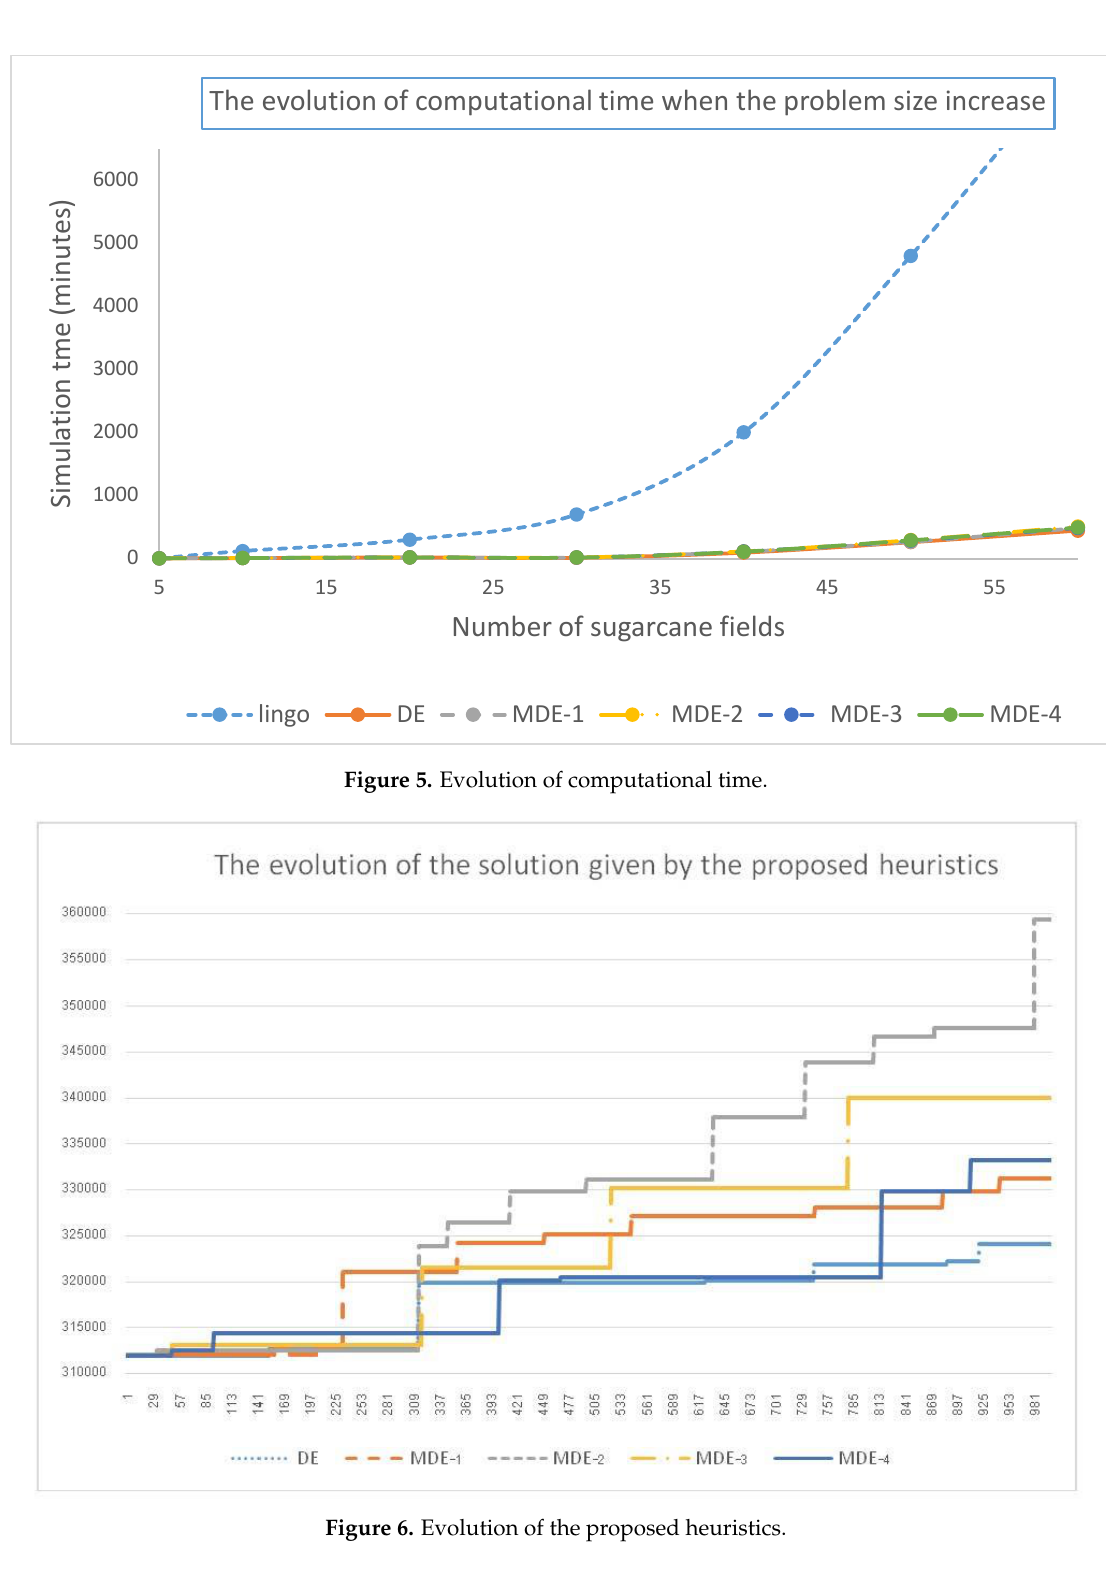
Figure 6. Evolution of the proposed